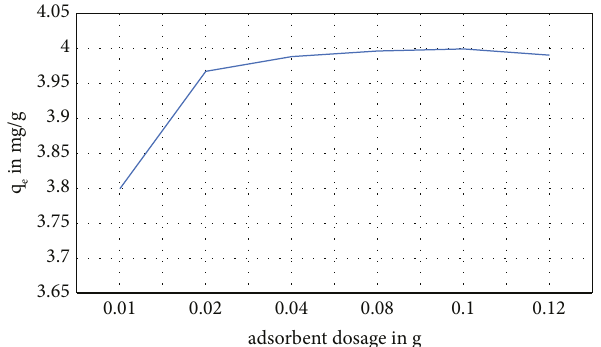
Figure 16: Adsorption of dieldrin onto nanocomposite at different contact times.